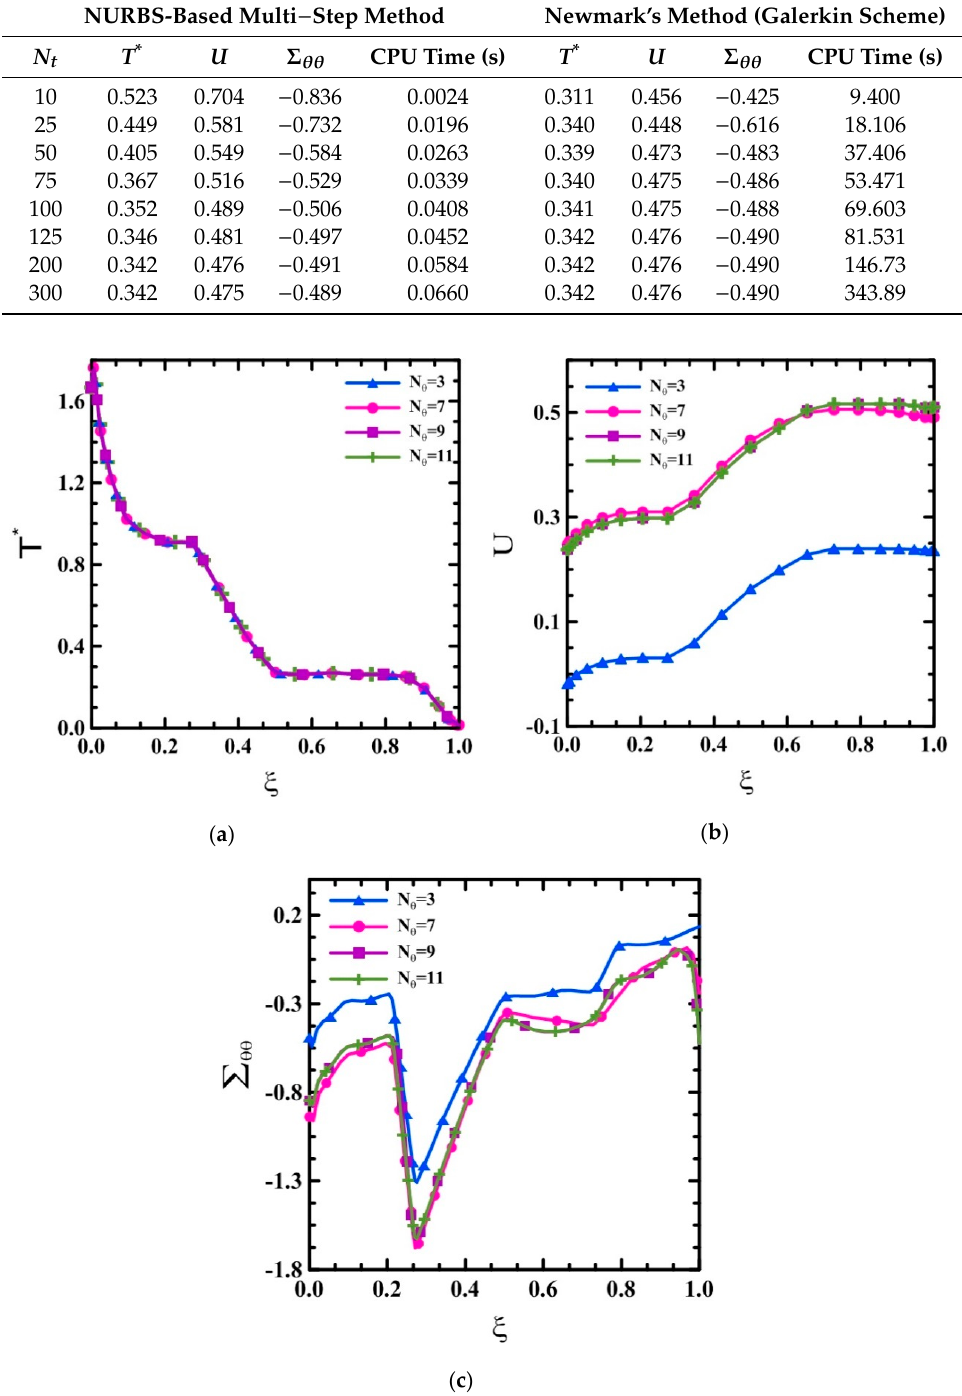
Figure 3. ( a – c ): Parametric analysis of the thermoelastic field variables vs. the number of grid points ( (cid:16) n = 1, h c / h p = 5, N ξ = 9, N t = 300, θ 0 = 75 ◦ , θ = 0.5 θ 0 , ψ = 0.03, F 0 = 0.8, τ = 0.2 Table 1. Material properties of ceramic (ZrO 2 ) and metal (Ti-6Al-4V) [11].